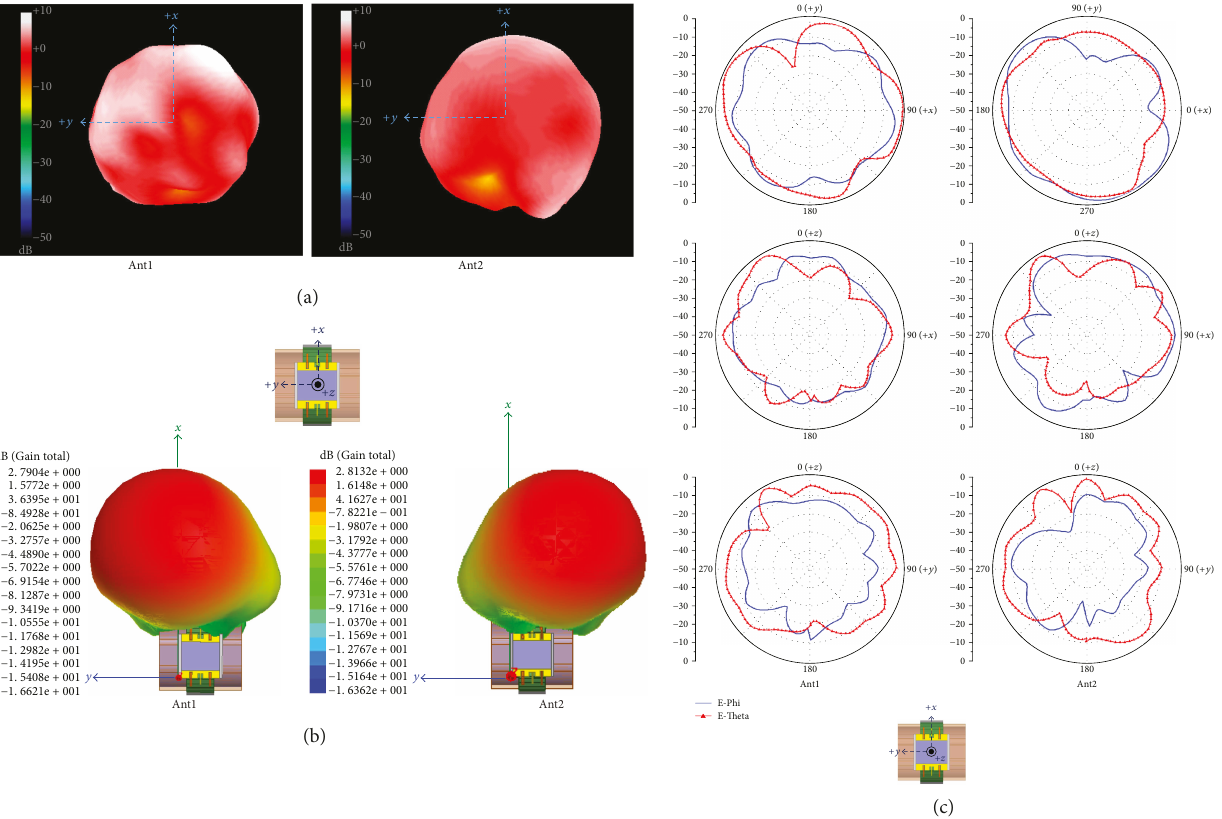
Figure 15: (a) Measured antenna 3D radiation patterns for the four-element MIMO antenna worn on the phantom hand. (b) Simulated 3D radiation patterns for the four-element MIMO antenna (at 5.5GHz) worn on the wrist model. (c) Measured 2D radiation patterns (at between the simulated and measured values in Figures 8 Figure 14(b). The simulated antenna e ffi ciencies are 49% – and 14 are observed due to the limitations of the measure- 58% over the operation band, and the simulated peak ment set-up or the fl exible substrate variations. gains are approximately 2.4 – 2.9 dBi. The di ff erence